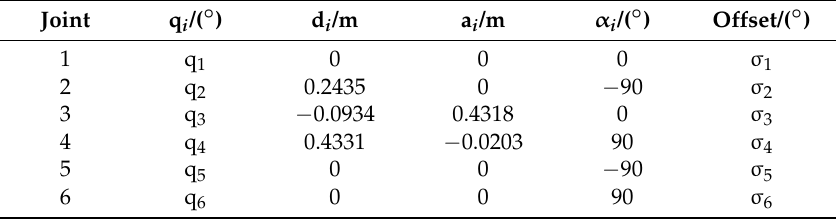
Table 2. Denavit–Hartenberg parameters of the PUMA560 robot for the synthetic